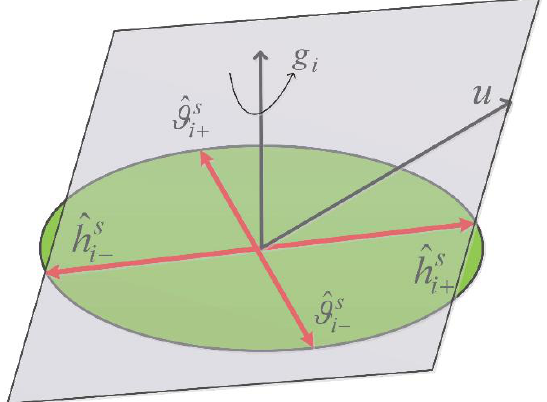
Figure 5. Singularity schematic diagram of the SGCMGs.